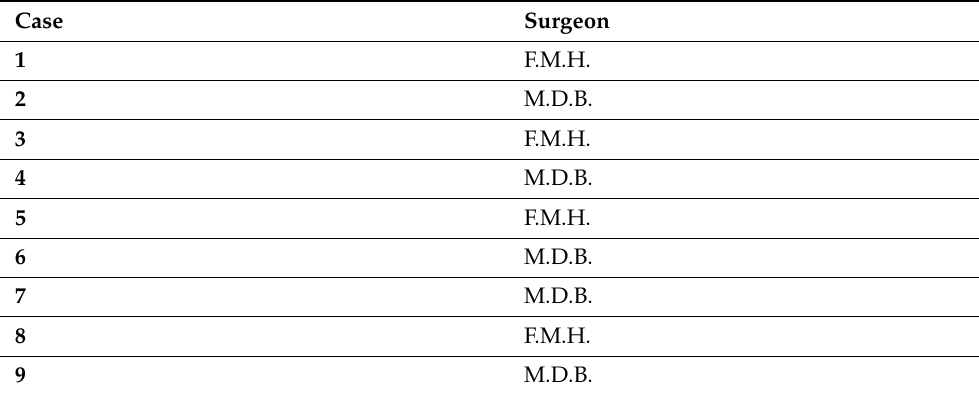
Table 2. Four surgeries were performed by surgeon F.M.H., and five surgeries were performed by surgeon